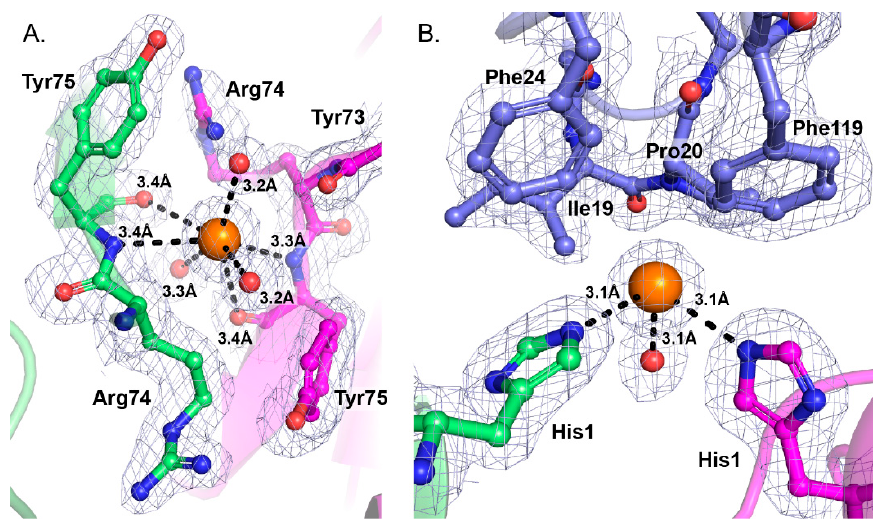
Figure 4. Interactions of chloride ions contribute to the stability of the tetrameric quaternary assembly. ( A ) Cl − binds to the polypeptide chains at Tyr75 from two adjacent monomers (chains A and B). Chains are colored as in Figure 3. ( B ) Cl − binds to the side chains of His1 from the two adjacent CB monomers (chains A and B). Additional bonds are made with nearby water molecules. Residues within 4 Å are labeled and shown as sticks. The bond distances are indicated. Chloride ions are represented as orange spheres and coordinating water molecules are shown as red spheres. The electron density map is contoured at the 1.0 sigma level.